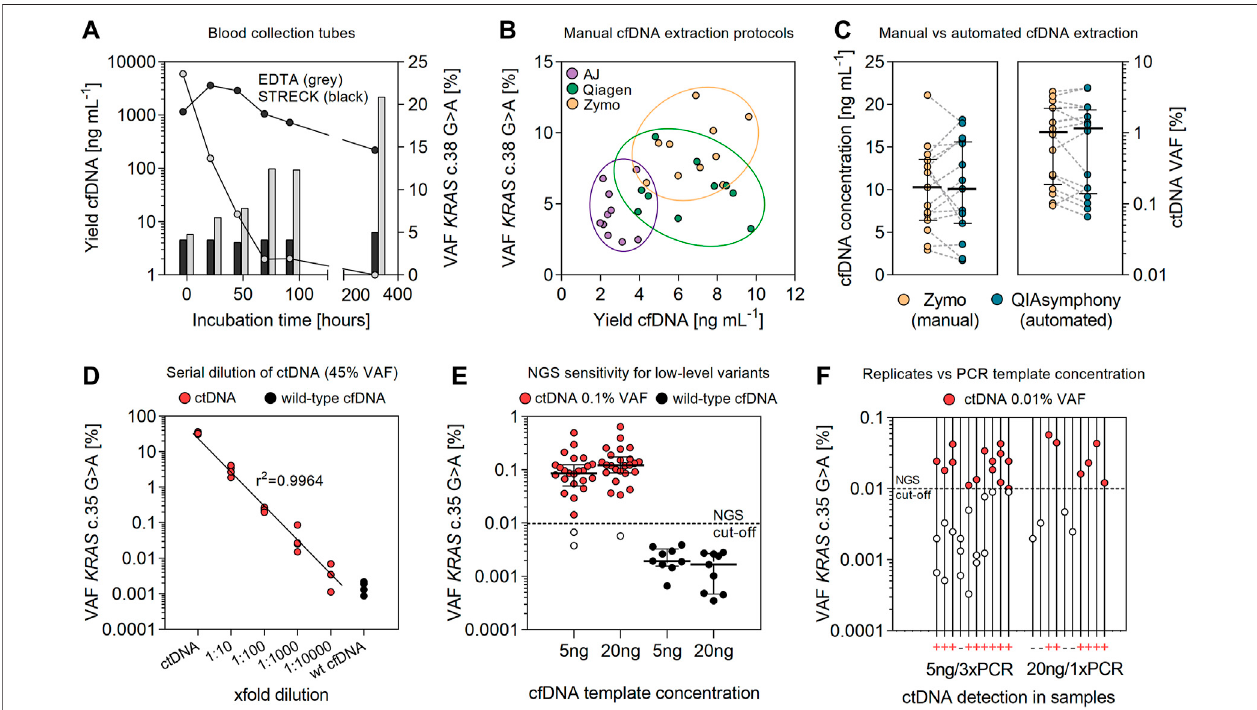
FIGURE 1 | Optimizing cfDNA preservation and extraction for sensitive detection of ctDNA. (A) Stability of ctDNA in EDTA and Streck blood collection tubes. Data forplasmalevelsofcfDNA[ng mL − 1 plasma]andthefrequencyofcorresponding KRAS c.38G > Amutantalleles [%]represent meanvaluesofmultiplereplicates( n (cid:1) 4). (B) Comparing the ef fi ciency of manual cfDNA extraction kits for total extraction yield [ng mL − 1 plasma] and the detection of ctDNA [%]. Data are shown for different vendors: Analytik Jena (AJ), Qiagen, and Zymo Research. Extractions were performed in duplicate from plasma samples (1 – 3 ml) of CRC patients ( n (cid:1) 5). (C) Extraction yield [ng mL − 1 plasma] and concentrations of detected ctDNA [%] in plasma samples (2.5 ml) of CRC patients ( n (cid:1) 15) (median coverage 121,825; range 70,027 – 179,931 reads). Extraction of cfDNA was performed using the manual protocol by Zymo Research and on a QIAsymphony instrument. Error bars represent median values and interquartile range. (D) Serial dilution (10-fold) of ctDNA (45% VAF) in wild-type cfDNA (median coverage 147,954; range 127,981 – 201438 reads). PCRwasperformedusingtheQ5polymerase(NEB),40PCRcyclesand30 ngofcfDNAasPCRtemplate. (E) NGSsensitivityforthedetectionoflow-levelctDNA(0.1% VAF)incfDNAsamples( n (cid:1) 25)using5or20 ngofcfDNAastemplateforPCRampli fi cation(mediancoverage114,830;range71,321 – 323,158reads).Wild-typecfDNA ( n (cid:1) 9) was used to measure the speci fi c false-positive rate (substitution error) for the detection of the KRAS c.35G > A variant. (F) Detection of ctDNA at the NGS cutoff for quanti fi cation (0.01% VAF) in cfDNA samples of CRC patients ( n (cid:1) 10) (median coverage 137,989; range 114,597 – 194,558 reads). Variant calling was performed using reads from a single PCR with 20 ng cfDNA input or by the integration of sequencing reads from pooled triplicate PCRs and 5 ng of cfDNA as